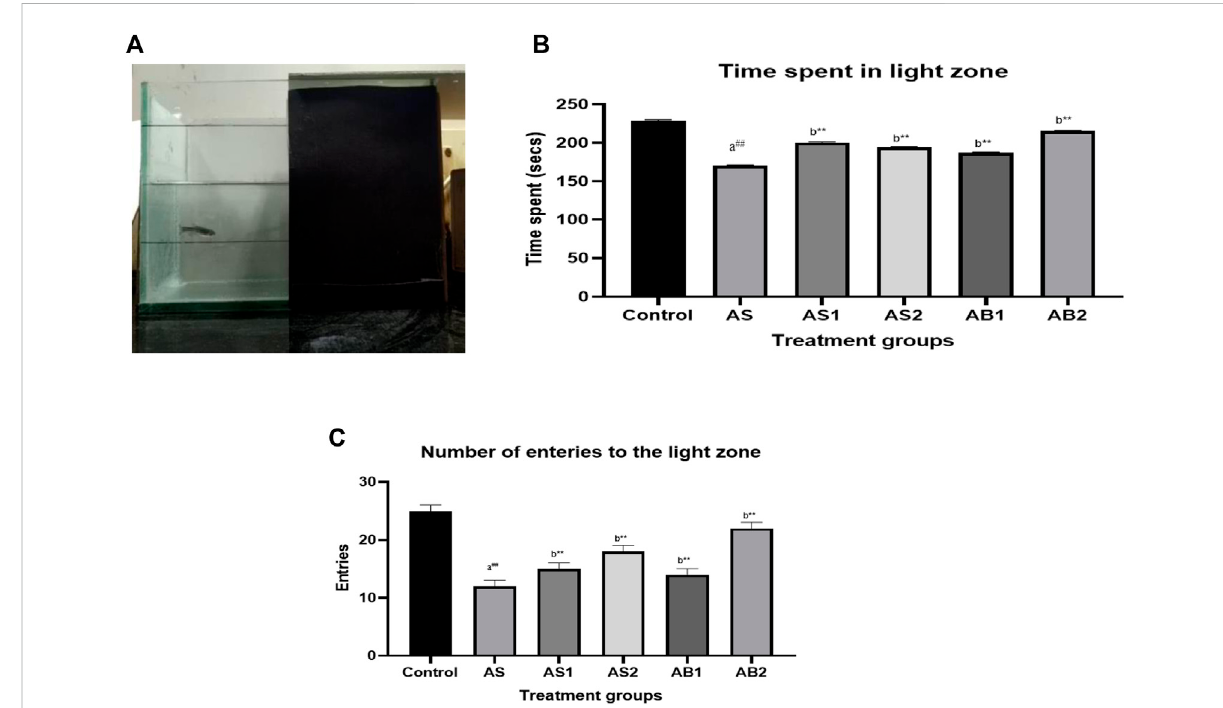
FIGURE 8 (A) Lightdarktestofdrug-treatedgroupofzebra fi sh(AS) (B) Theeffectoftreatmentontimespentinthelightzoneofthetank(AS) (C) Theeffect of treatment on entries to the light zone of the tank (AS). Values are presented as the mean ± S.E.M. A one-way ANOVA followed by Bonferroni post hoc test was used ( n = 8 – 10). (A) Comparisons were made between the Stressed group (AS) with normal control. (B) Comparisons were made between AS1, AS2, and AB1 andAB2 with the stressed group (AS). p-value ***represents p < 0.001, **represents p < 0.01, *represents p < 0.05, ## represents p < 0.01, ns represents being not signi fi cant.